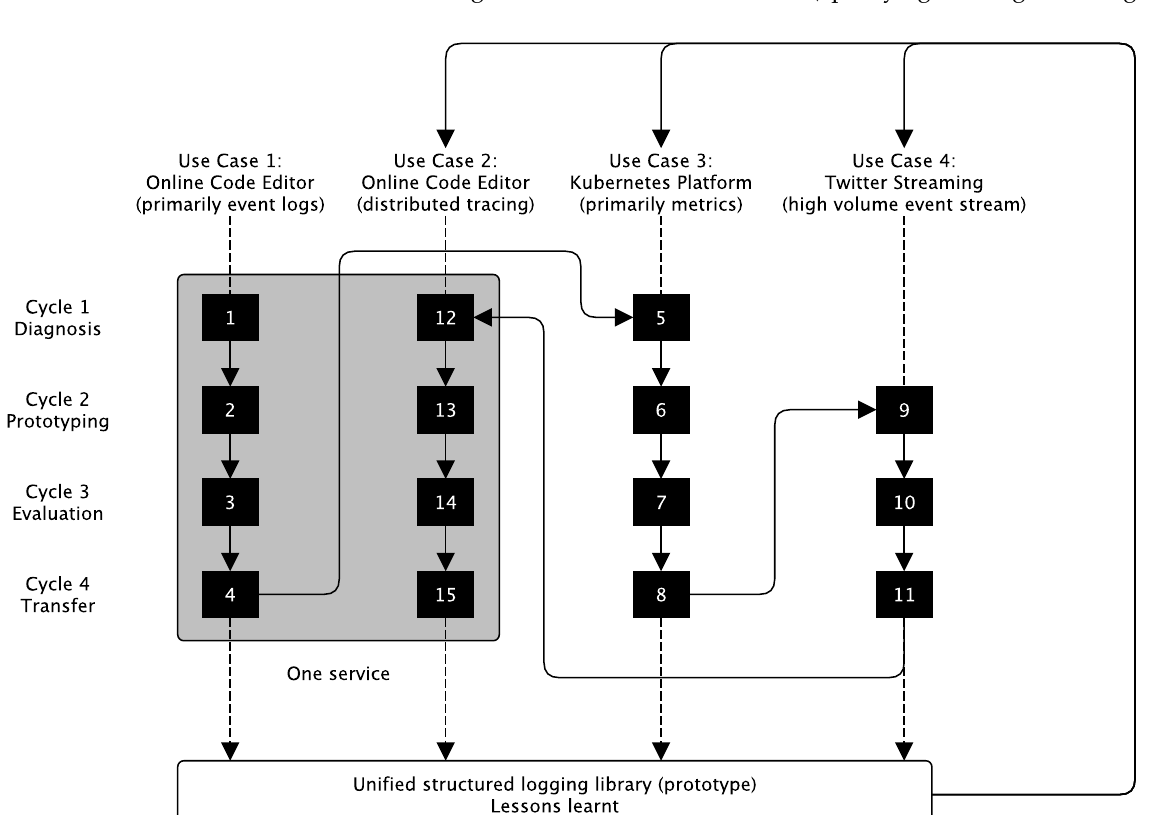
Figure 3. Action research methodology of this